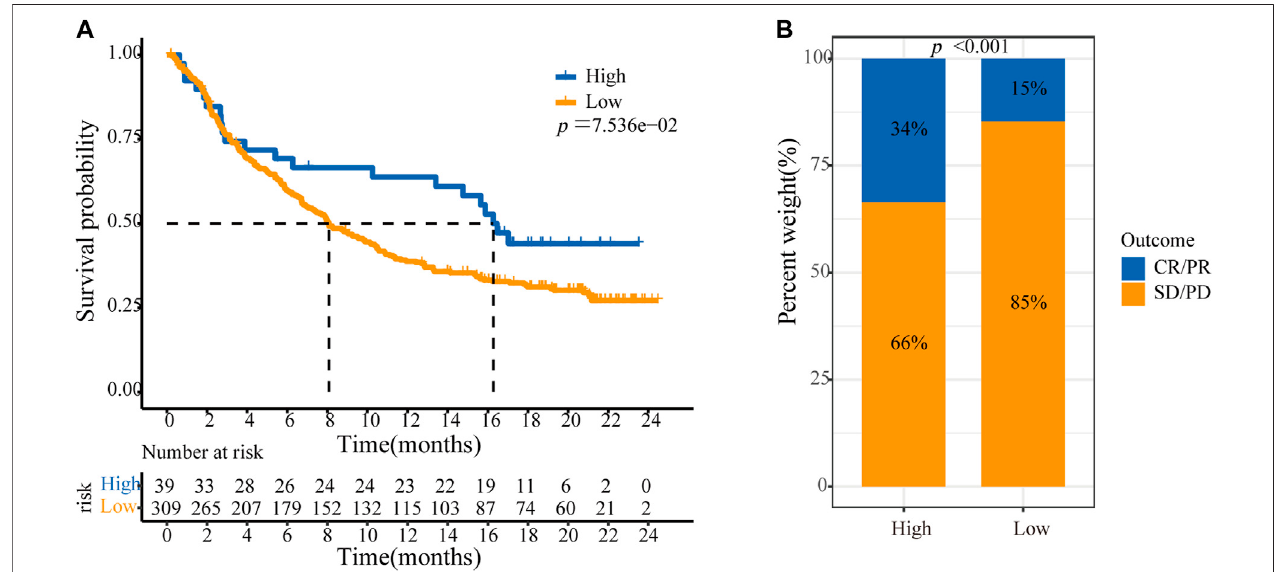
FIGURE 10 | ASF1B predicts immunotherapy ef fi cacy. (A) Kaplan – Meier analysis of OS according to the level of ASF1B expression among patients using immunotherapy; (B) The immunotherapy ef fi cacy in ASF1B high and low expression groups. CR, complete response; PR, partial response; SD, stable disease; PD, progressive